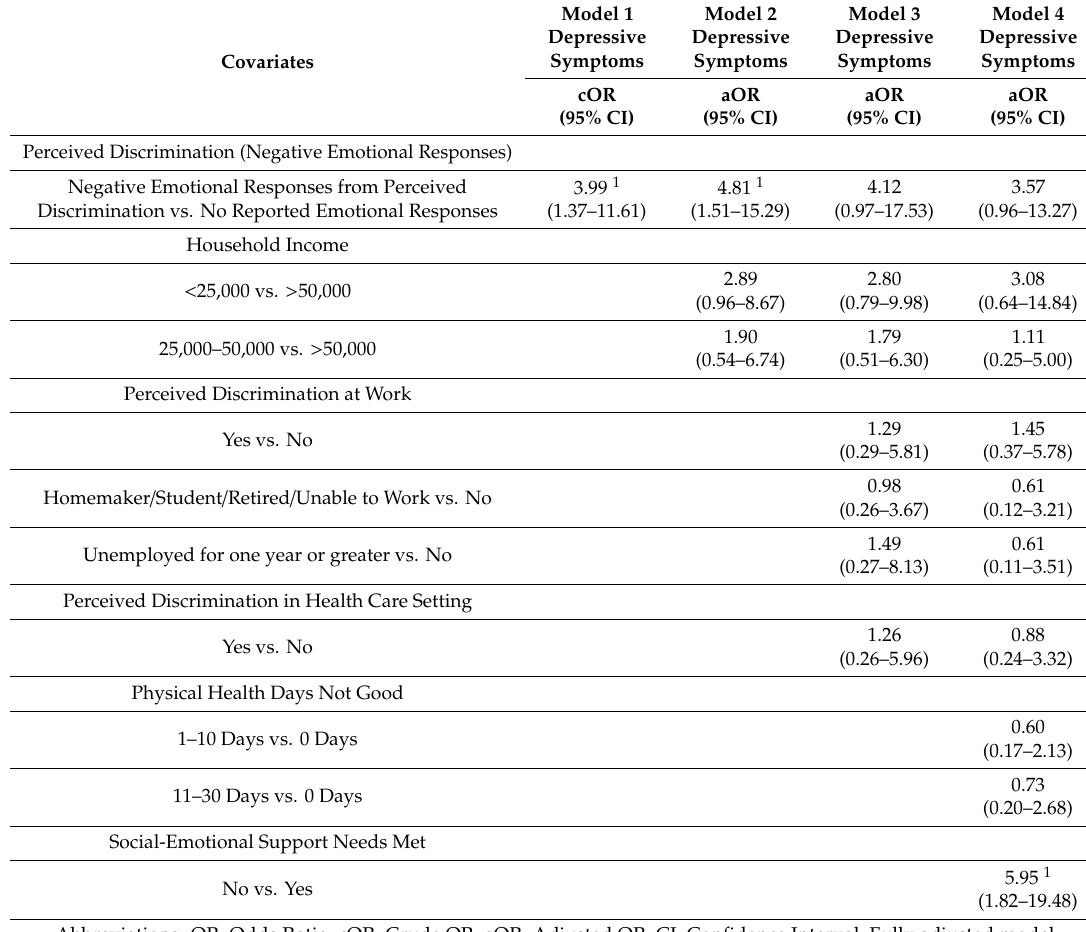
Table 4. Crude and adjusted associations between emotional responses to perceived discrimination and self-reported depressive symptoms among African American (AA) men in the Southeastern United States, BRFSS 2010. Model 1 Depressive Covariates